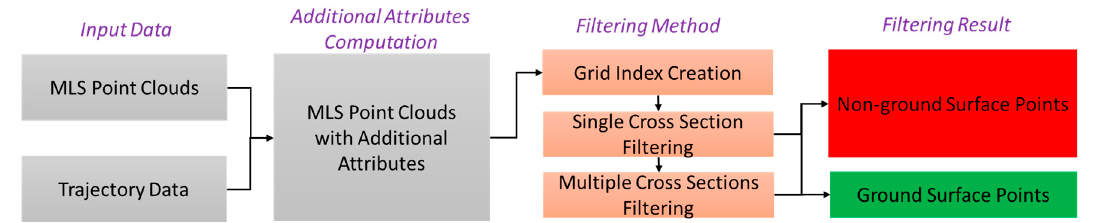
Figure 5. Workflow of the proposed filtering method.